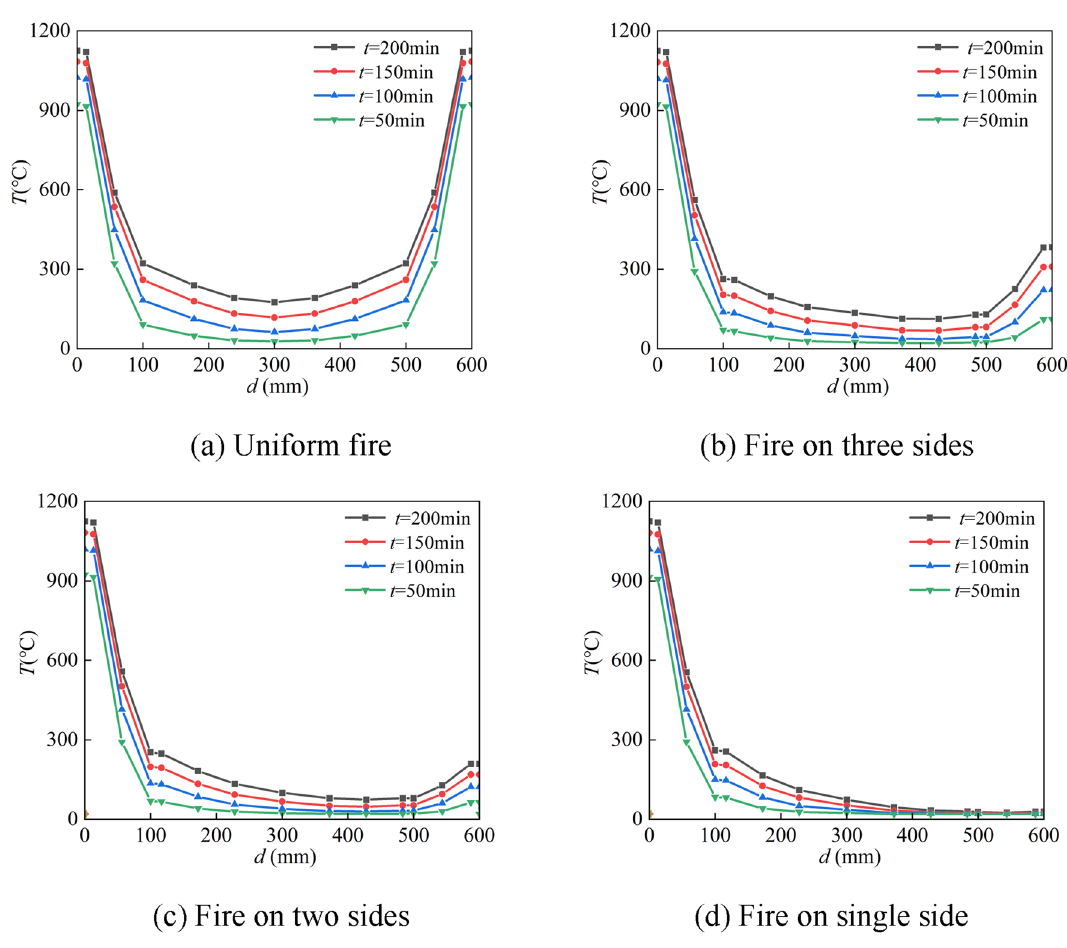
Figure 11. Temperature-depth